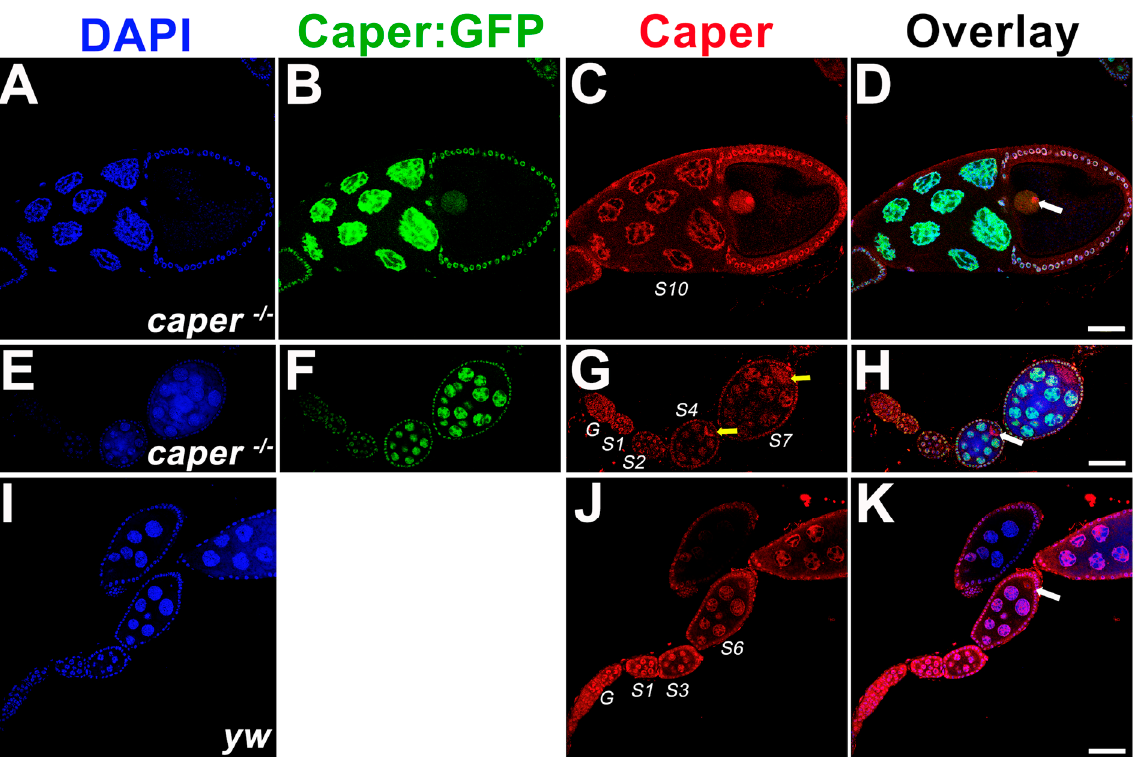
Figure 1 . Caper is expressed throughout the female germline. Single z-plane confocal slices indicate that caper − / − ovarioles ( A – H ) show normal patterning as compared to yw ovarioles ( I – K ). Nuclei are marked with DAPI in blue ( A , E , I ). The Caper:GFP fusion protein ( B , F ) is shown in green and marks nurse cell nuclei, the oocyte nucleus and follicle cell nuclei. An anti-Caper antibody shown in red ( C , G , J ) marks nurse cell nuclei, the oocyte nucleus, follicle cell nuclei and is also found in the oocyte cytoplasm. Overlays of all channels are shown in ( D , H , K ). White arrows mark the oocyte nucleus. Yellow arrows show cytoplasmic expression of Caper marked with an anti-Caper antibody. A 50 micron scale bar is shown in ( K ).